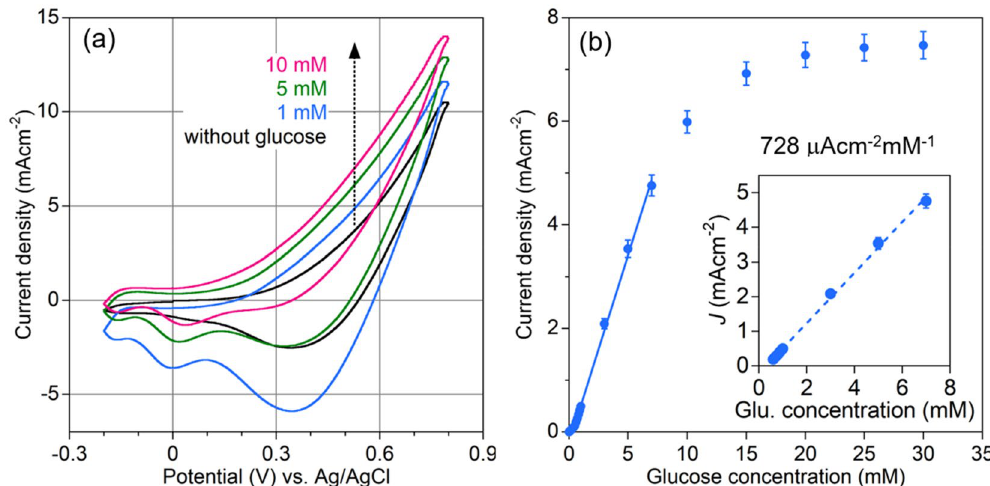
glucose concentration calibration curves. The curve is an average of three trials in every three sensors. The inset shows the focused cali- bration curves in the blood